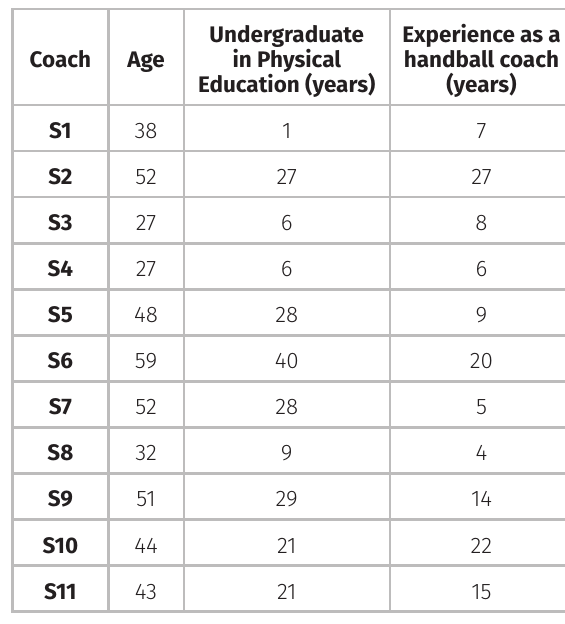
Table I. Characterization of school team